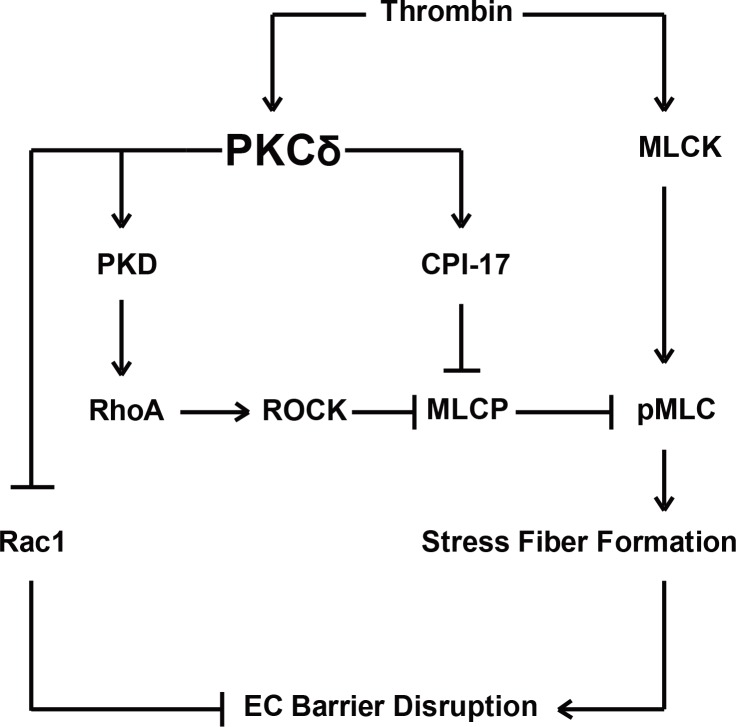
Proposed roles of PKCδ in thrombin-induced human lung EC barrier disruption through a pathway involving MLC and Rho GTPase.Thrombin activates PKCδ that then leads to the activation of PKD and CPI-17. In turn, PKD activates the RhoA pathway inducing MLC activation, while PKCδ phosphorylates CPI-17, a potent MLCP inhibitor, thereby resulting in increased MLC phosphorylation. MLC phosphorylation mediates actin stress fiber formation and contraction. In addition, PKCδ inhibits Rac1 activity blocking its barrier protective effects upon thrombin stimulation.